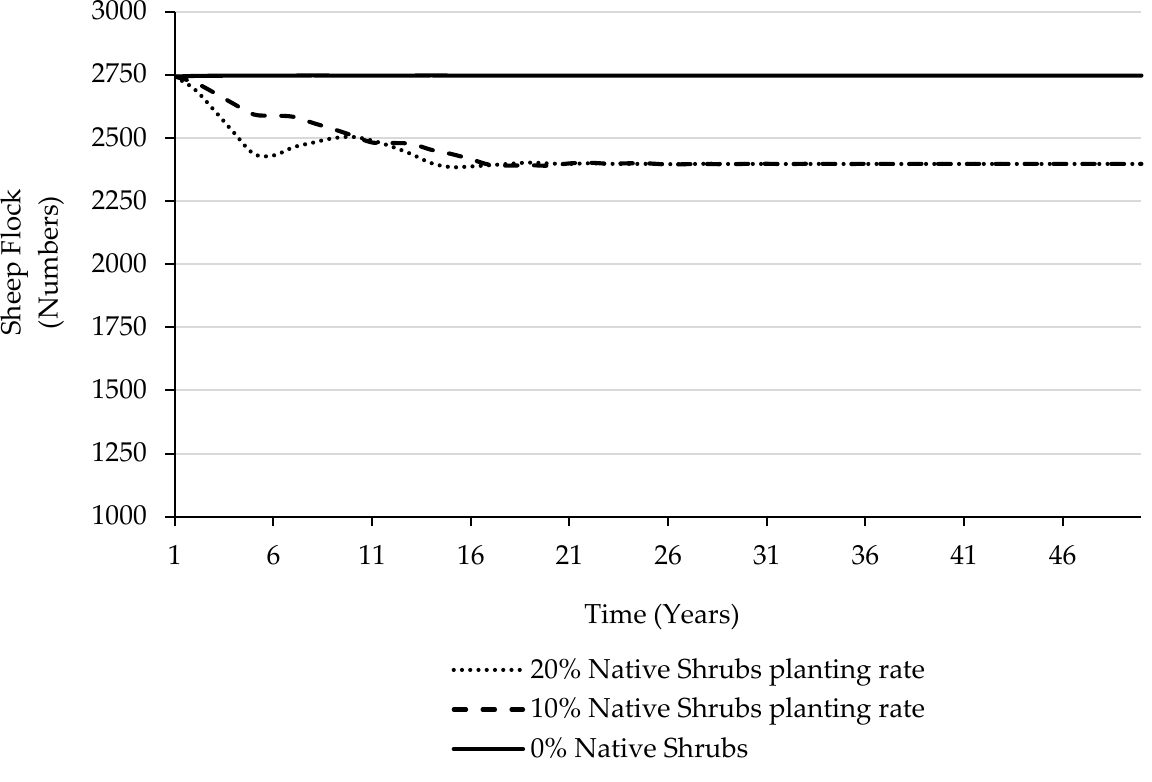
Figure 4. Fluctuation in sheep flock size with native shrubs planted on 10% of the modelled farm at 0%, 10%, and 20% planting rates per year, over 50 years.